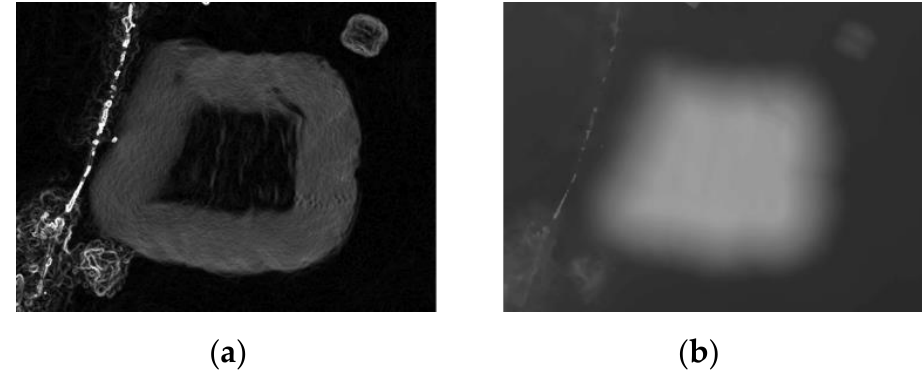
Figure 9. A heap shown ( a ) in “slope - view” and ( b ) in “height - view”.